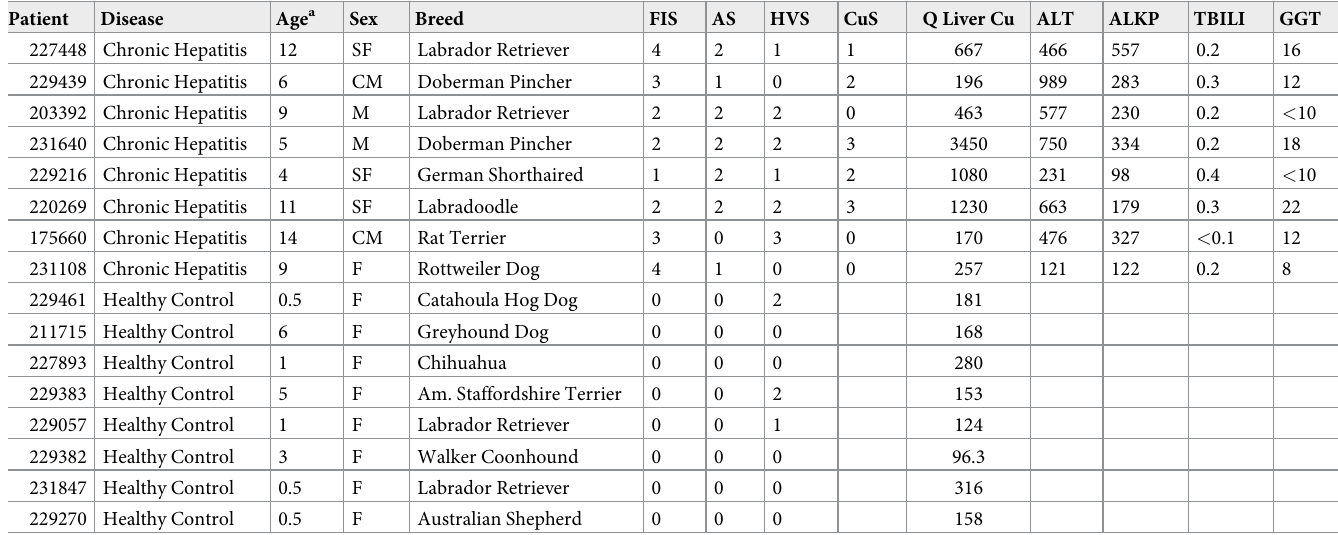
Table 1. Demographics and clinical characteristics of dogs enrolled into the